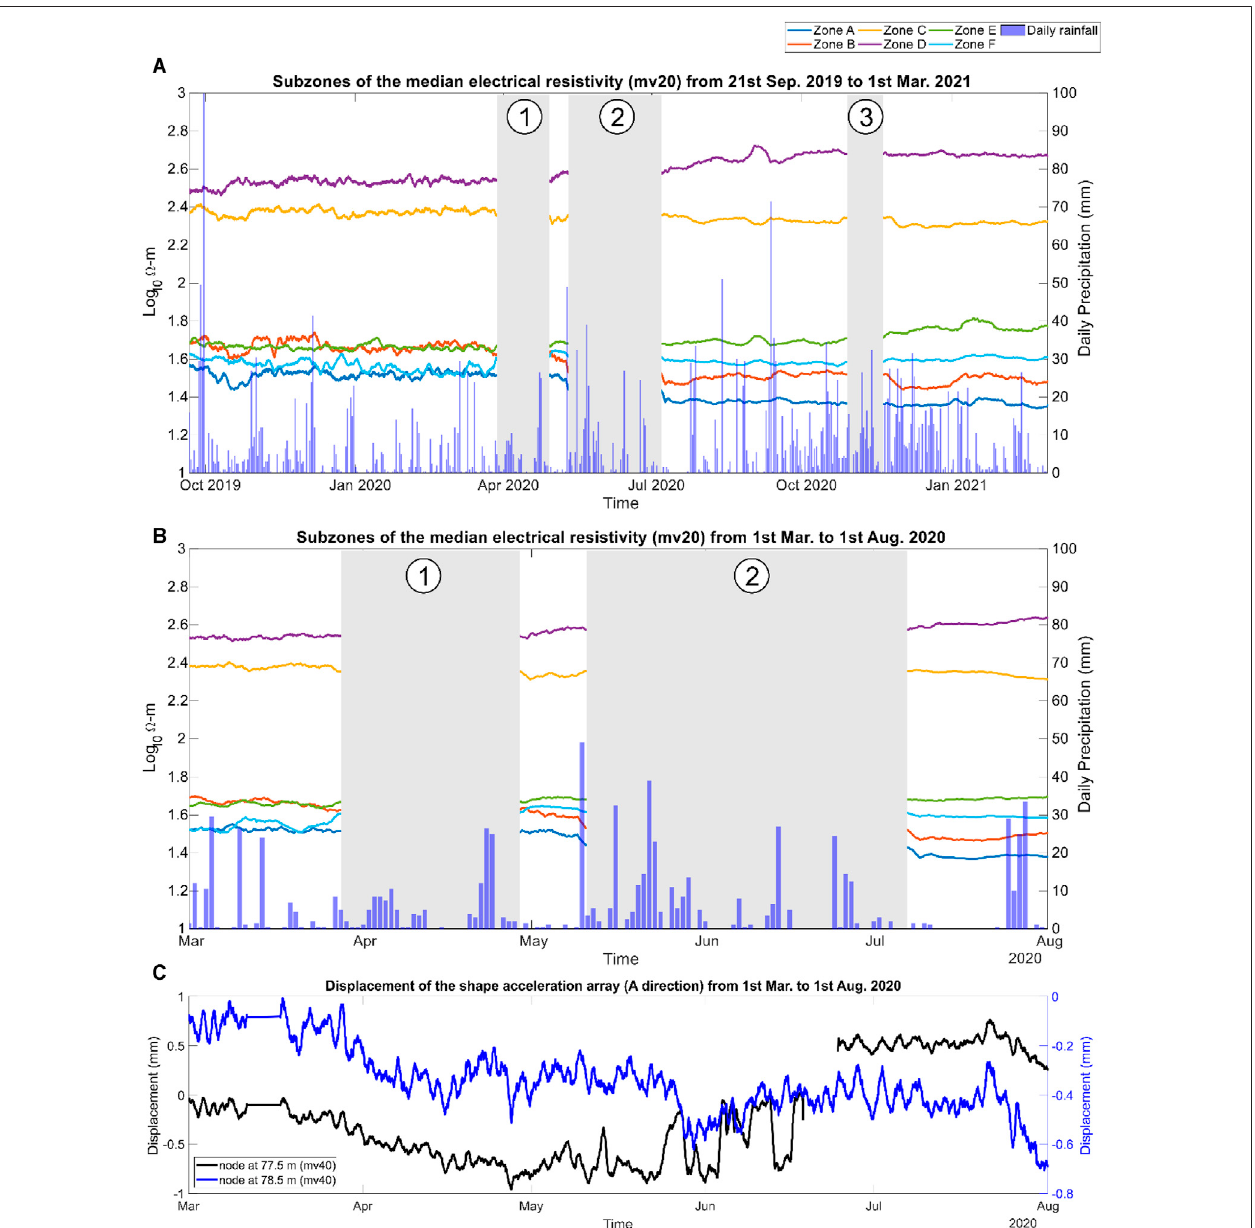
FIGURE 7 | Time series ofthe median electrical resistivity (MEER) curves overlaid with the daily rainfall data. (A) Moving average of 20measurements (mv20) of the MEERcurves from21Sept2019toMar1,2021.ThedarkbluelineindicatesZone A,theorangelineforZone B,theyellow lineZoneC,thepurplelineZone D,thegreen lineZone E, and the light blue line for Zone F. Three gray zones labeled withNumbers 1-3 represent three periods when ERTmeasurements were interrupted dueto the R2MS system damages caused by lightning strikes. (B) A zoom-in for the MEER curves from Mar 1 to Aug 1, 2020, to compare with the SAA data. (C) Horizontal displacement at the depths of 77.5 and 78.5 m is estimated from the SAA